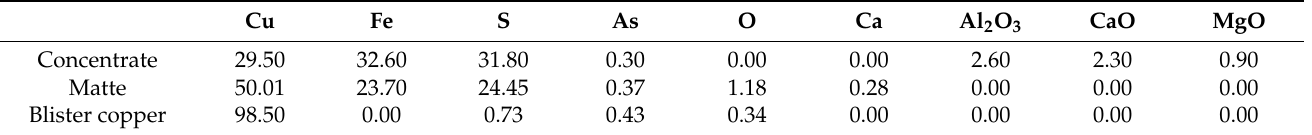
Table 2. Typical compositions of copper concentrate, matte, and blister